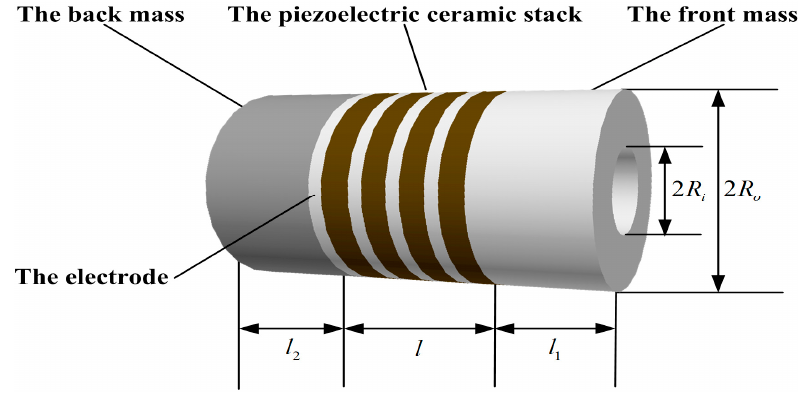
Figure 1. Simplified structure diagram of a sandwich piezoelectric ultrasonic transducer.